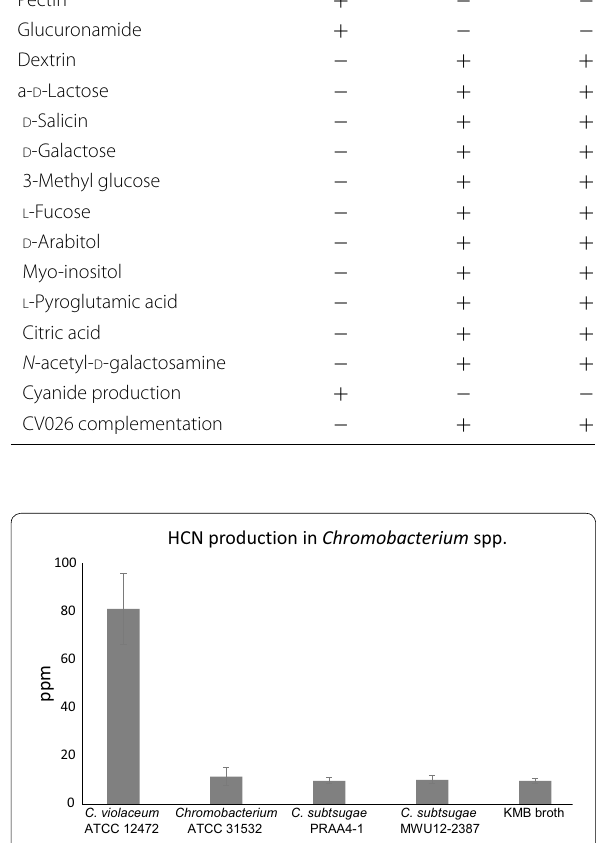
Fig. 3 Hydrogen cyanide production in Chromobacterium app. isolates. C. violaceum produces about 70 ppm HCN. C.